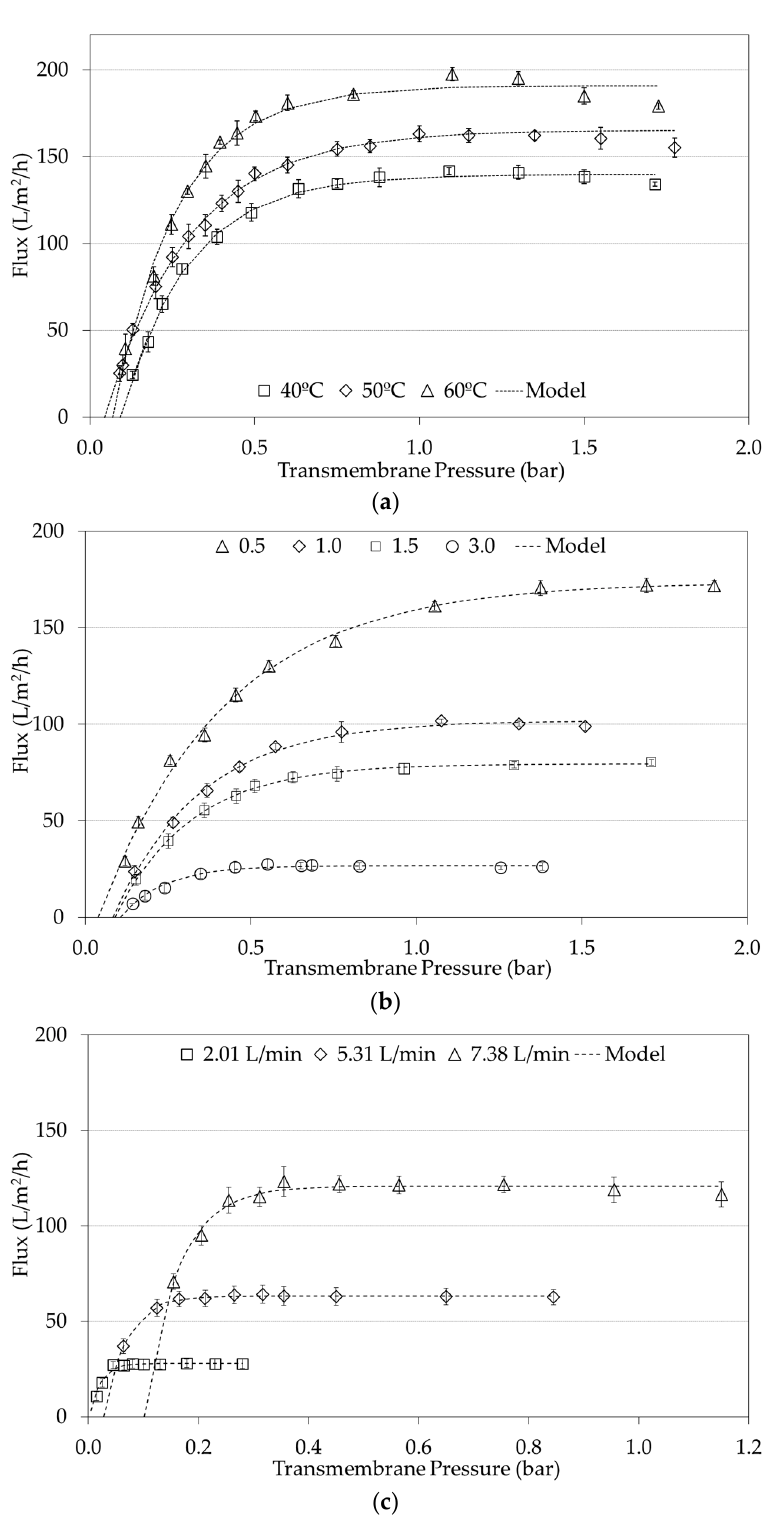
Figure 3. E ff ects of processing conditions on the flux versus transmembrane pressure. ( a ) E ff ect of Temperature. Experimental conditions: concentration factor of 0.5 at 7.38 L / min using the membrane with a d h of 6 mm. ( b ) E ff ect of the Concentration Factor. Experimental conditions: flow of 7.38 L / min at 60 ◦ C using the membrane with a d h of 3.6 mm. ( c ) E ff ect of Flow. Experimental conditions: concentration factor of 1.5 at 60 ◦ C using the membrane with a d h of 2 mm